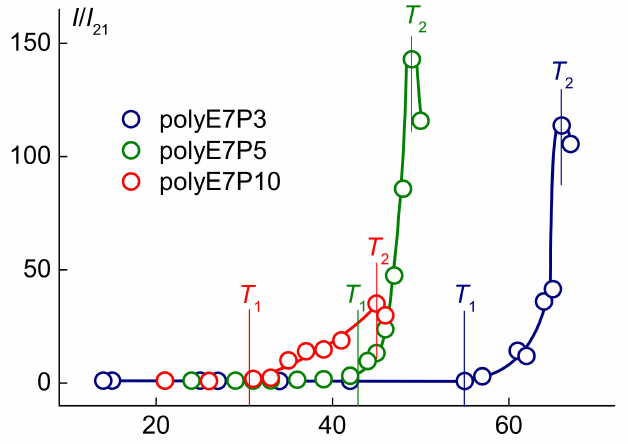
Figure 6. Temperature dependences of the relative light scattering intensity I / I 21 for the aqueous solutions of polyOEGeOPGpMA at concentration c ≈ 0.0050 g · cm − 3 . I 21 is light scattering intensity at 21 ◦ C.